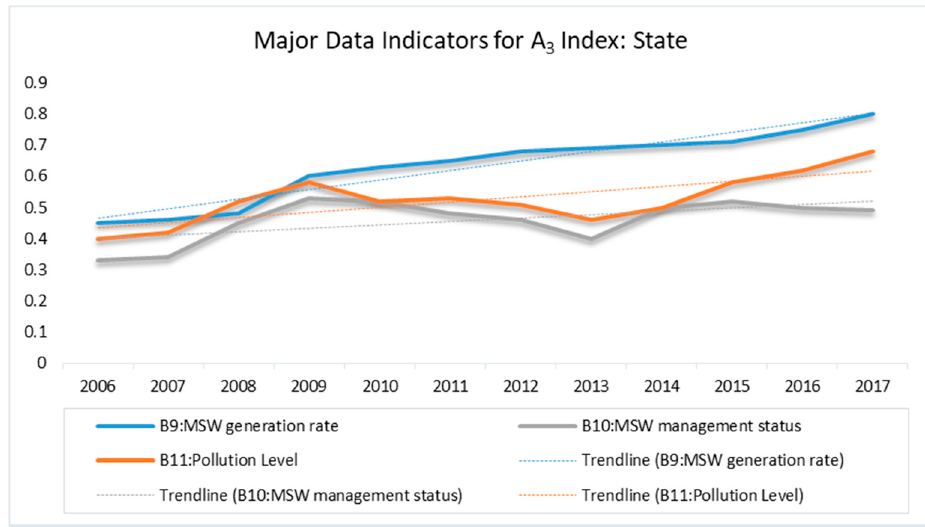
Figure 4. Major Data Indicators for A 3 Index: State.